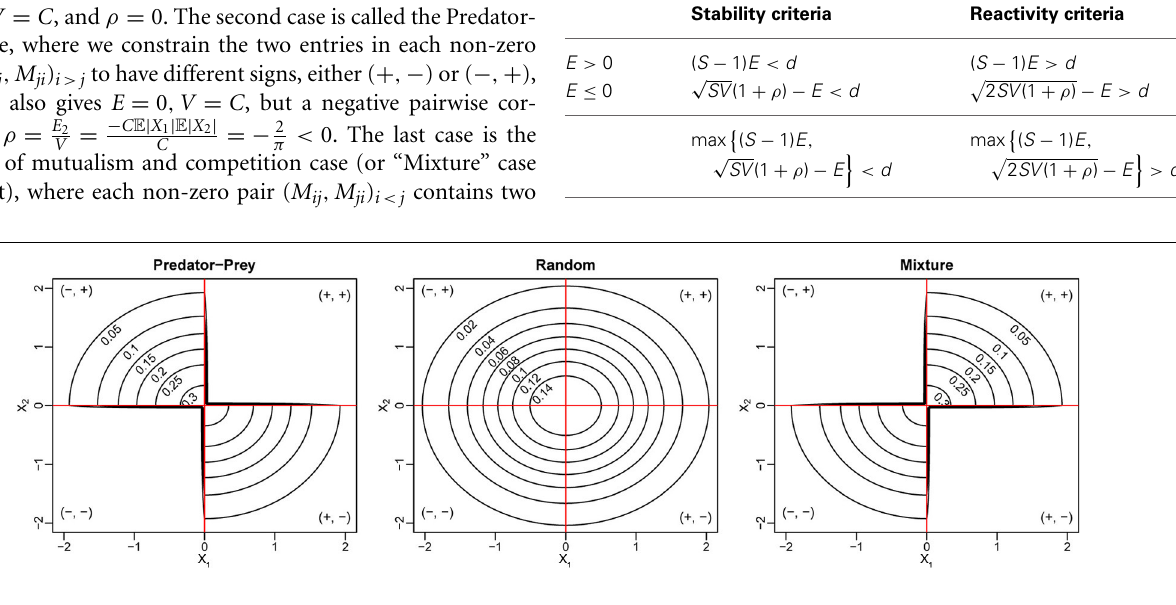
FIGURE 1 | Joint density contour for the bivariate distribution of ( X 1 , X 2 ) for three different types of ecological networks. In all three cases, the marginal distributions for both X 1 and X 2 are standard normal distributions.